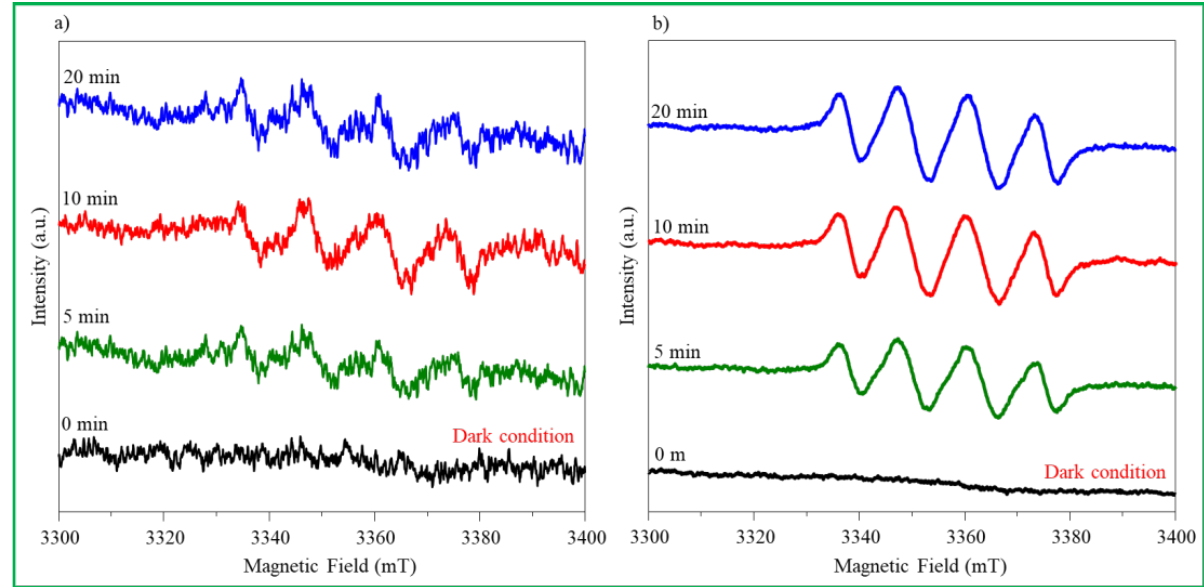
Figure 7. Spin-trapping ESR curves for ZnO− 4M particle. ( a ) OH radical, ( b ) ∙O 2 − radical.